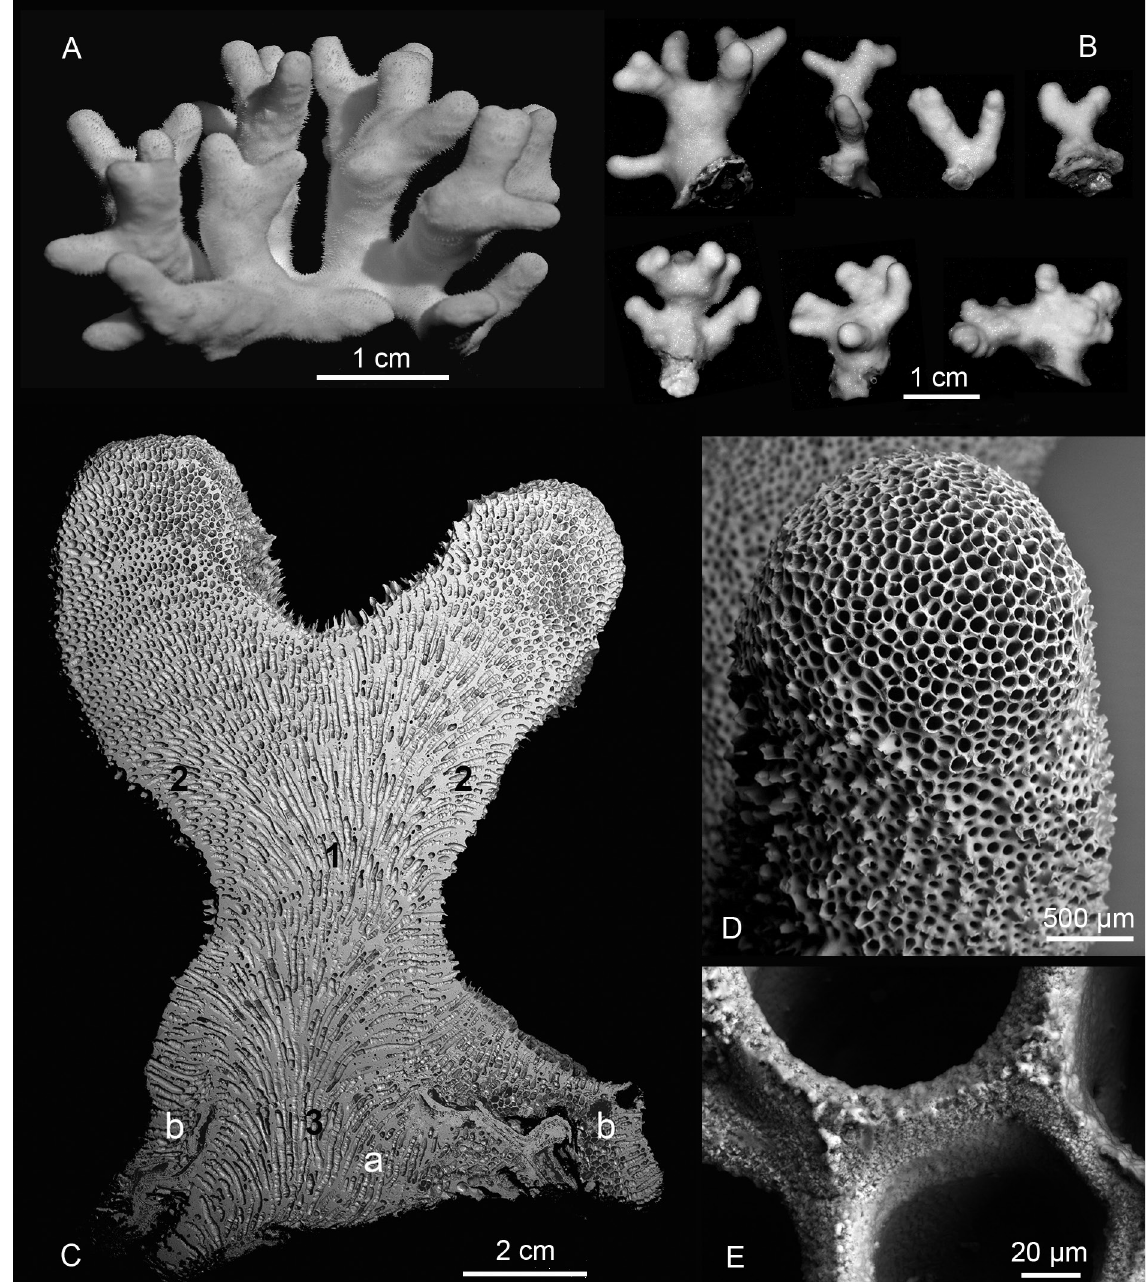
Fig. 2. Photographs (A–B) and scanning electron micrographs of Disporella guada Harmelin, Taylor & Waeschenbach sp. nov. A . Holotype, specimen kept dry (MNHN-IB-2017-696). B . Seven variously shaped colonies (top row, left to right: NHMUK 2021.2.25.1, 2021.3.19.2, 2018.1.15.63, 2021.3.19.1; bottom row, left to right: NHMUK 2021.6.14.1, 2021.6.14.2, 2021.6.14.3). C . Longitudinal section of a specimen (NHMUK 2021.3.19.1) with two branches; 1: endozone, 2: exozone, 3: basal part with central primary attachment zone (3a) and secondary peripheral attachment zone (3b). D–E . NHMUK 2021.3.19.2. D . Growing tip. E . Interzooecial walls at growing